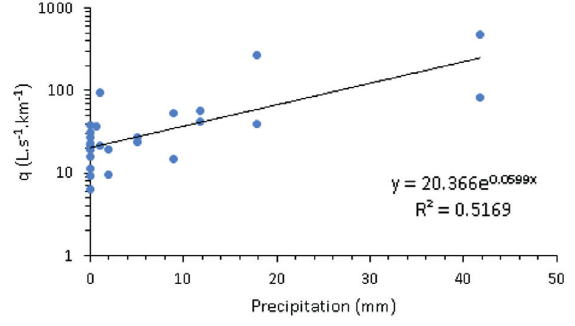
Figure 6 - Rates of flow increase obtained along the channel as a function of daily